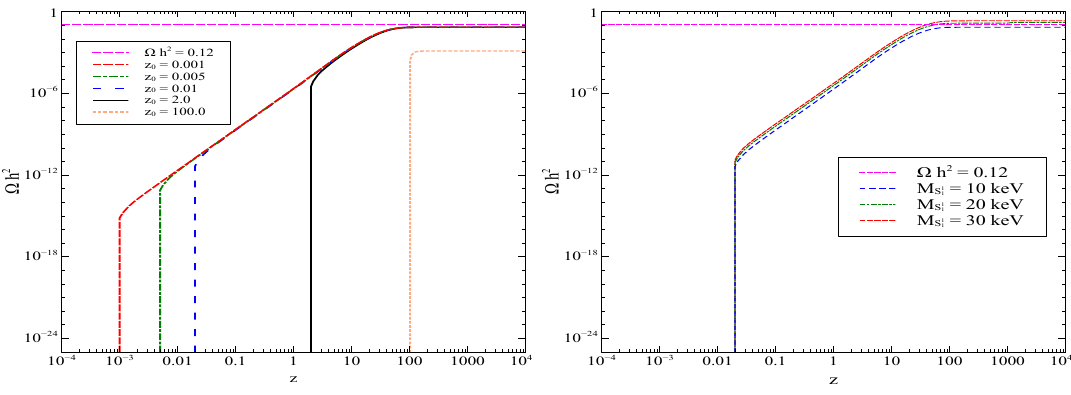
Figure 3 . Variation of DM relic density, for the annihilation contribution only, as a function of z for di(cid:11)erent values of z 0 (left), where M (right), where z 0 = 0 : 01. Here, g 0 = 12 : 5 (cid:2) 10 (cid:0) 10 , M Z 0 = 10 GeV, M h